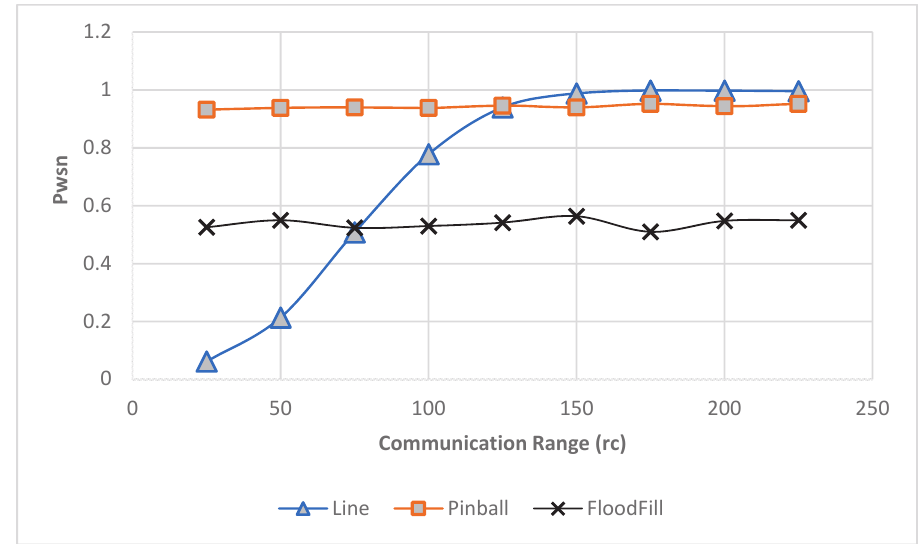
Figure 11. The WSN win probability ( P wsn ) of a WSN in detecting and preventing an intruder that adopts the linear, pinball and flood-fill algorithms in a WSN with varying communication range r c